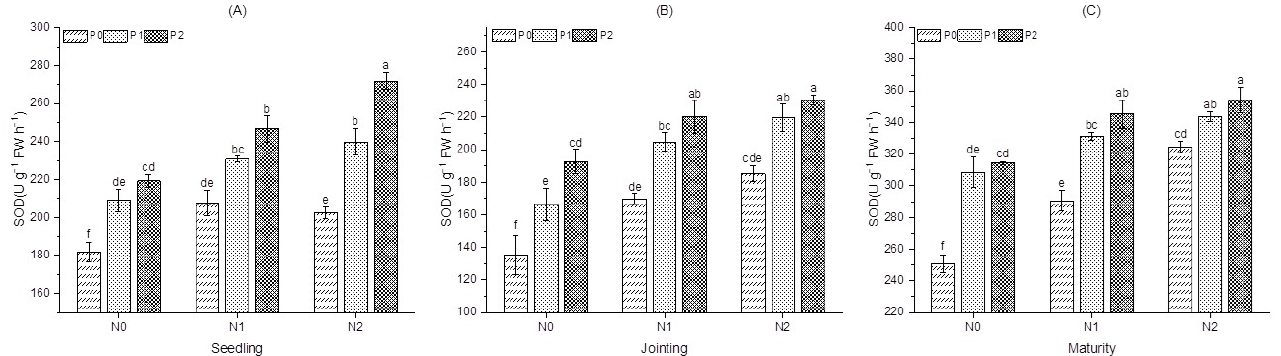
Figure 1. Effects of nitrogen and phosphorus on superoxide dismutase (SOD) activity of sorghum plants grown in saline soils at the three growing stages of seedling, jointing, and maturity. ( A ) Seedling stage; ( B ) Jointing stage; ( C ) Maturity stage. Within each sampling date, the data followed by different letters are statistically different at the 0.05 probability level.